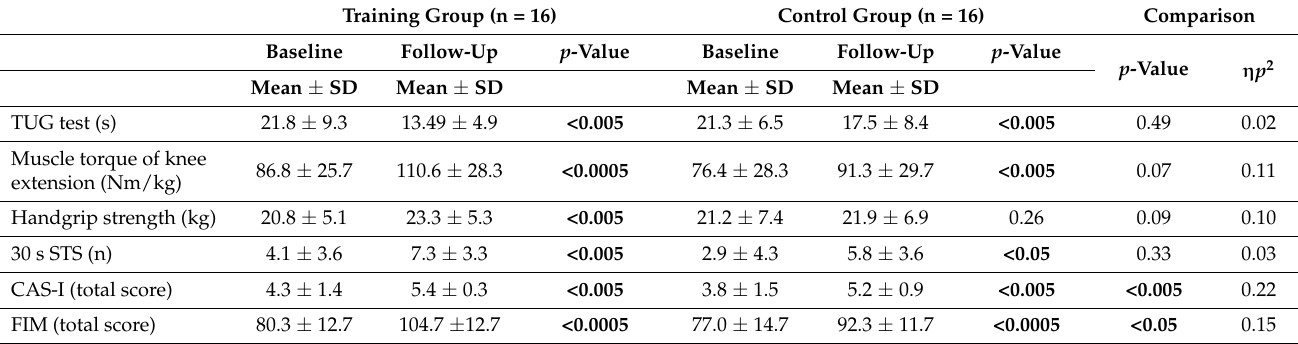
Table 2. Secondary outcomes (n =